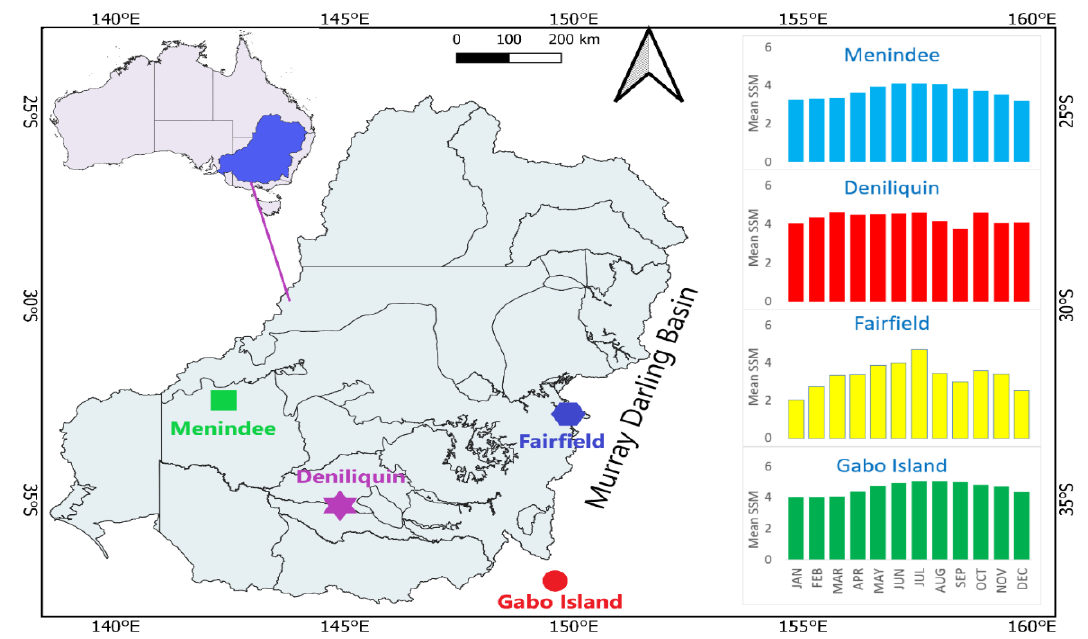
Figure 2. The Australian Murray Darling Basin with study sites and Surface Soil Moisture (SSM, kgm − 2 ) where the hybrid CEEMDAN-CNN-GRU model at multi-step daily SSM